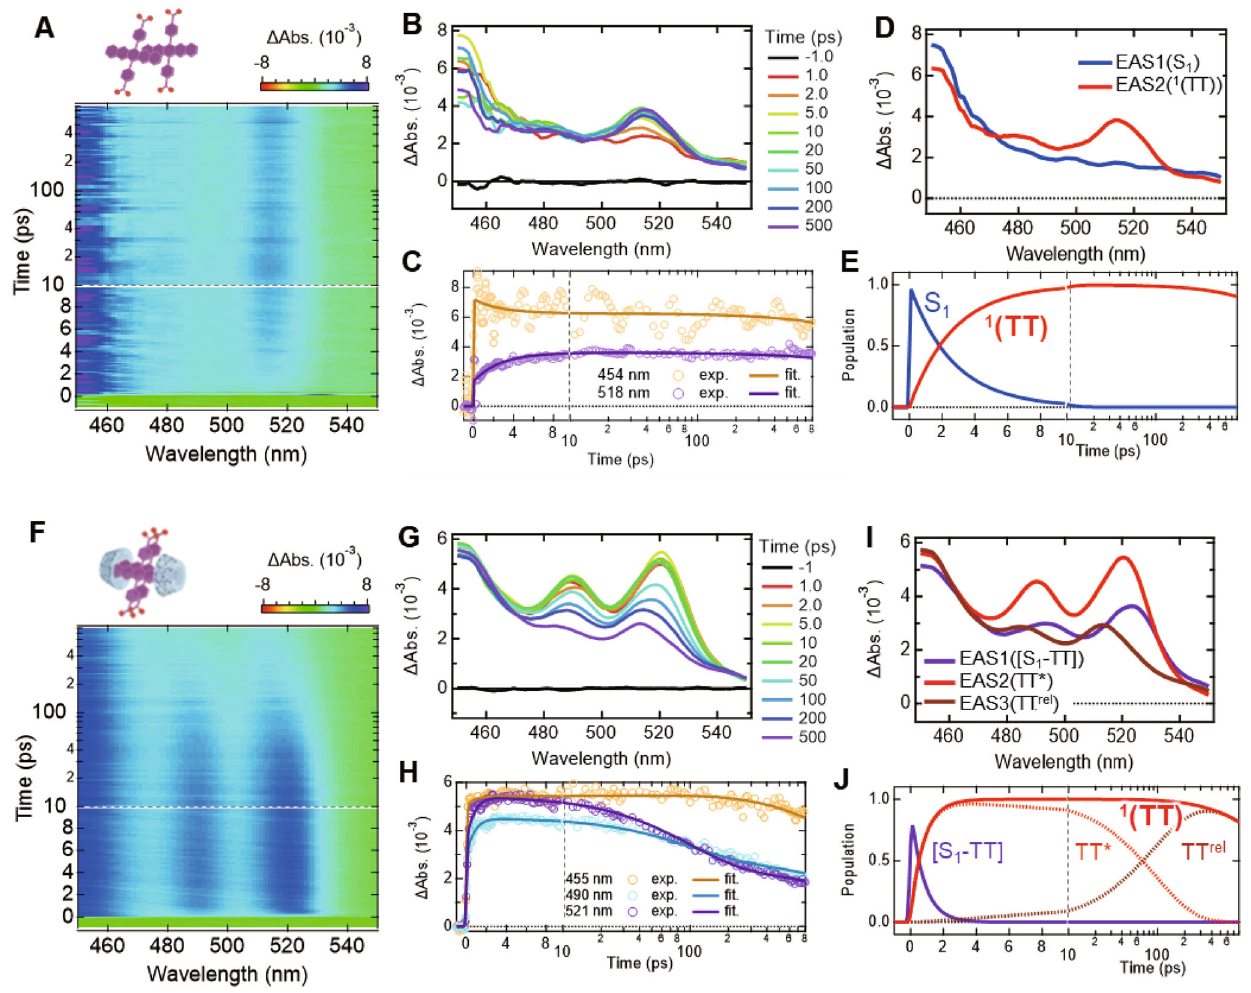
C , H temporal change of transient absorption at selected wavelengths and fi tting curves from global analysis. D , I Evolution-associated spectra (ESA) and E , J corresponding concentration kinetics obtained from global analysis based on sequential models. EAS1, EAS2, and EAS3 indicate the fi rst, second and third com- ponents of EAS,